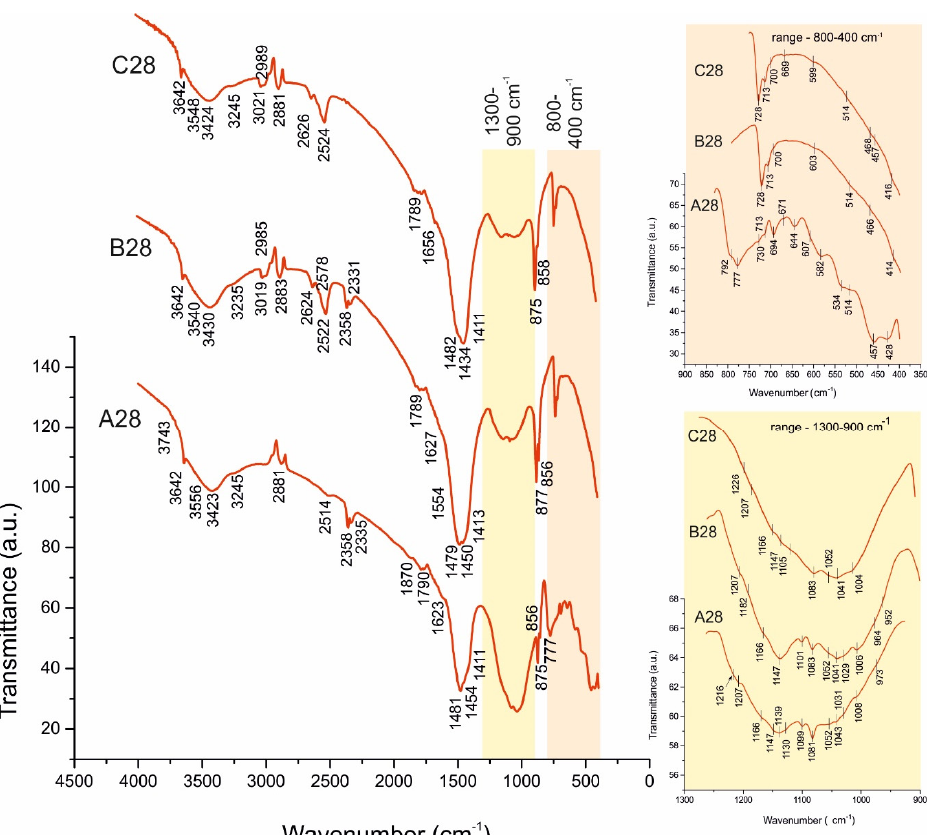
Figure 5. FTIR spectra of A028, B028, and C028. Magnifications: spectral ranges 1300–900 cm − 1 , and 900–350 cm − 1 . Materials 2021 , 14 , x FOR PEER REVIEW